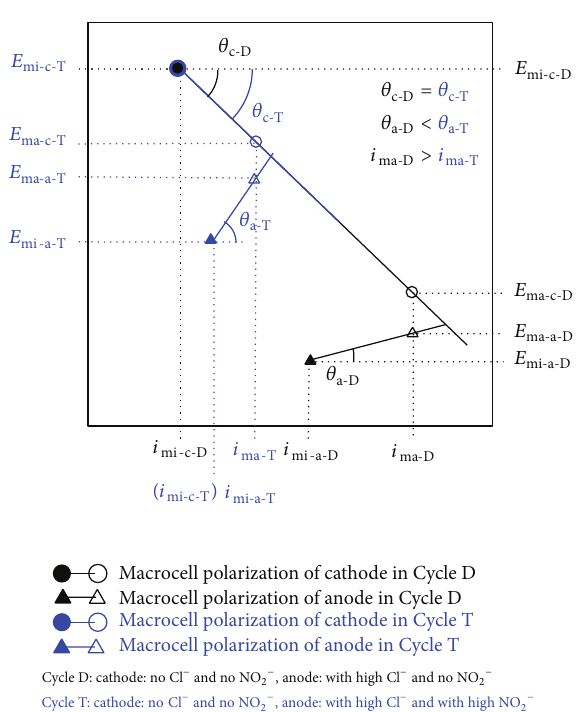
Figure 11: Mechanism of macrocell corrosion affected by nitrite